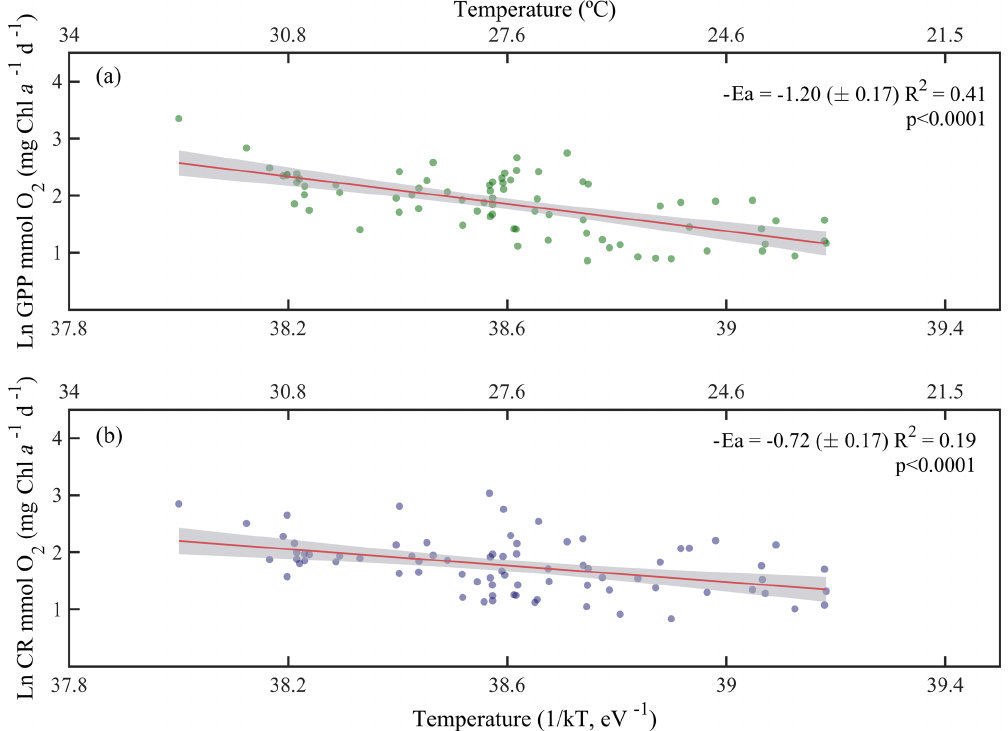
Figure 7. Arrhenius plots indicating temperature dependence of planktonic metabolic rates plotted as the relationship between the natural logarithm of (a) chlorophyll a -normalised gross primary production and (b) chlorophyll a -normalised planktonic community respiration with temperature as a function of 1 /kT (lower axis), where k is the Boltzmann’s constant (8 . 2 × 10 − 5 eVK − 1 ), and T denotes the absolute temperature (K). The corresponding temperatures in degree Celsius are shown in the upper axis for each graph. The solid red line is the linear least square fit and the shaded grey area represents the 95% confidence interval. E a represents the activation energy ( E a = negative